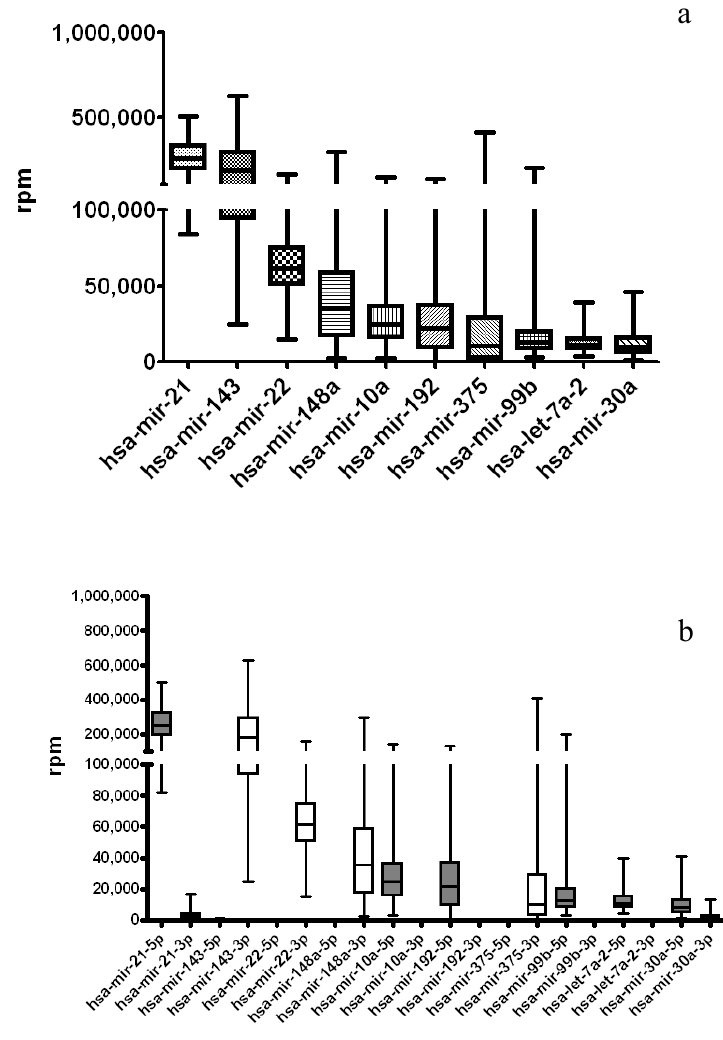
Figure 4. Distribution of highly expressed miRNAs in 261 gastric cancer samples from TCGA (The Cancer Genome Atlas) datasets. miRNA expression data of TCGA stomach adenocarcinoma (STAD) were retrieved and re-analyzed using the comprehensive arm feature annotated miRNA list. ( a ) The rpm values of each miRNAs were tabulated by combining the 5p-arm and 3p-arm to represent the miRNA loci expression; ( b ) 5p-arm and 3p-arm expression levels were tabulated separately and displayed. miR-21 is the most expressed miRNAs in the TCGA clinical cancer